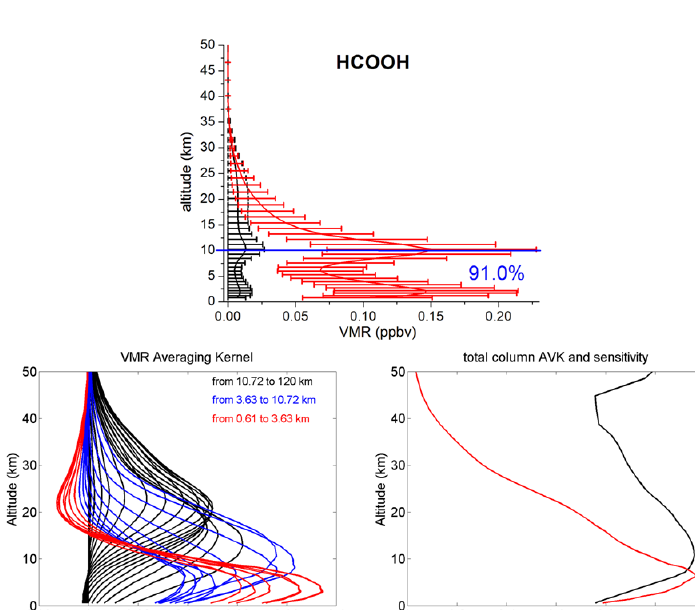
Figure 7. Same as Fig. 3 but for CH 3 OH.